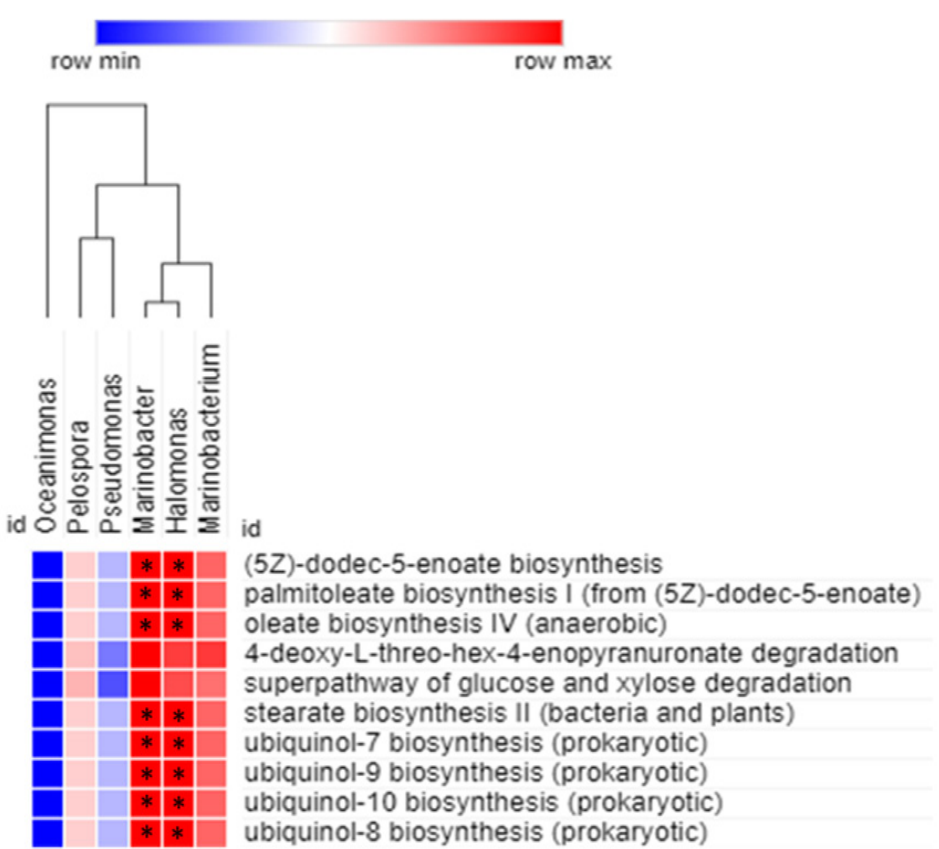
Figure 8. Spearman correlation analysis between bacterial genera of the mud volcanic site and their metabolic functional predictions. The positive and negative correlations are shown in red and blue colors, respectively. The correlation was considered significant at * p < 0.05.